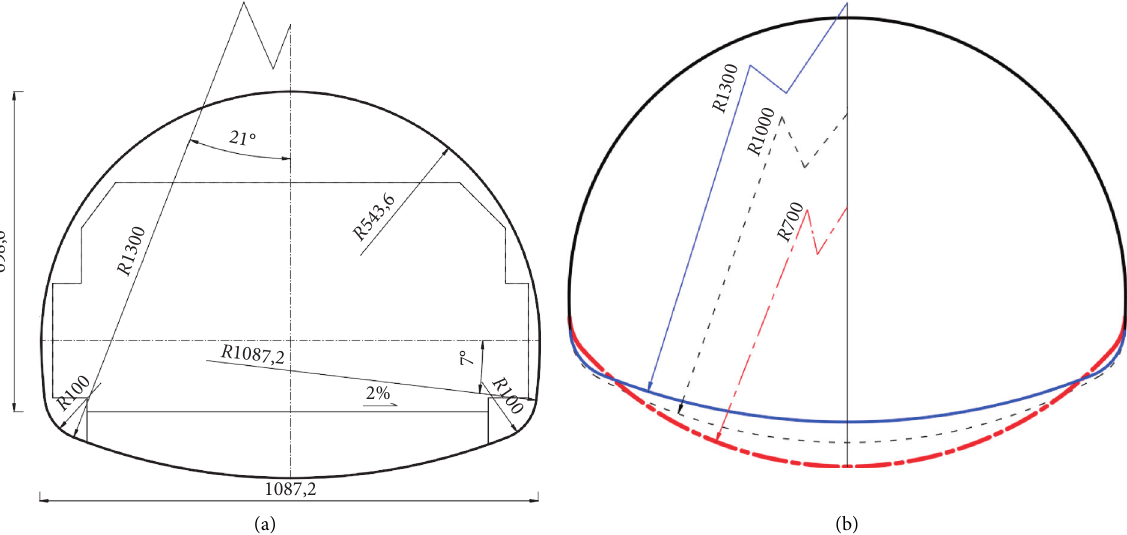
Figure 14: The tunnel outline (unit: cm). (a) The design parameters of the tunnel. (b) The tunnel outline of three radii of the